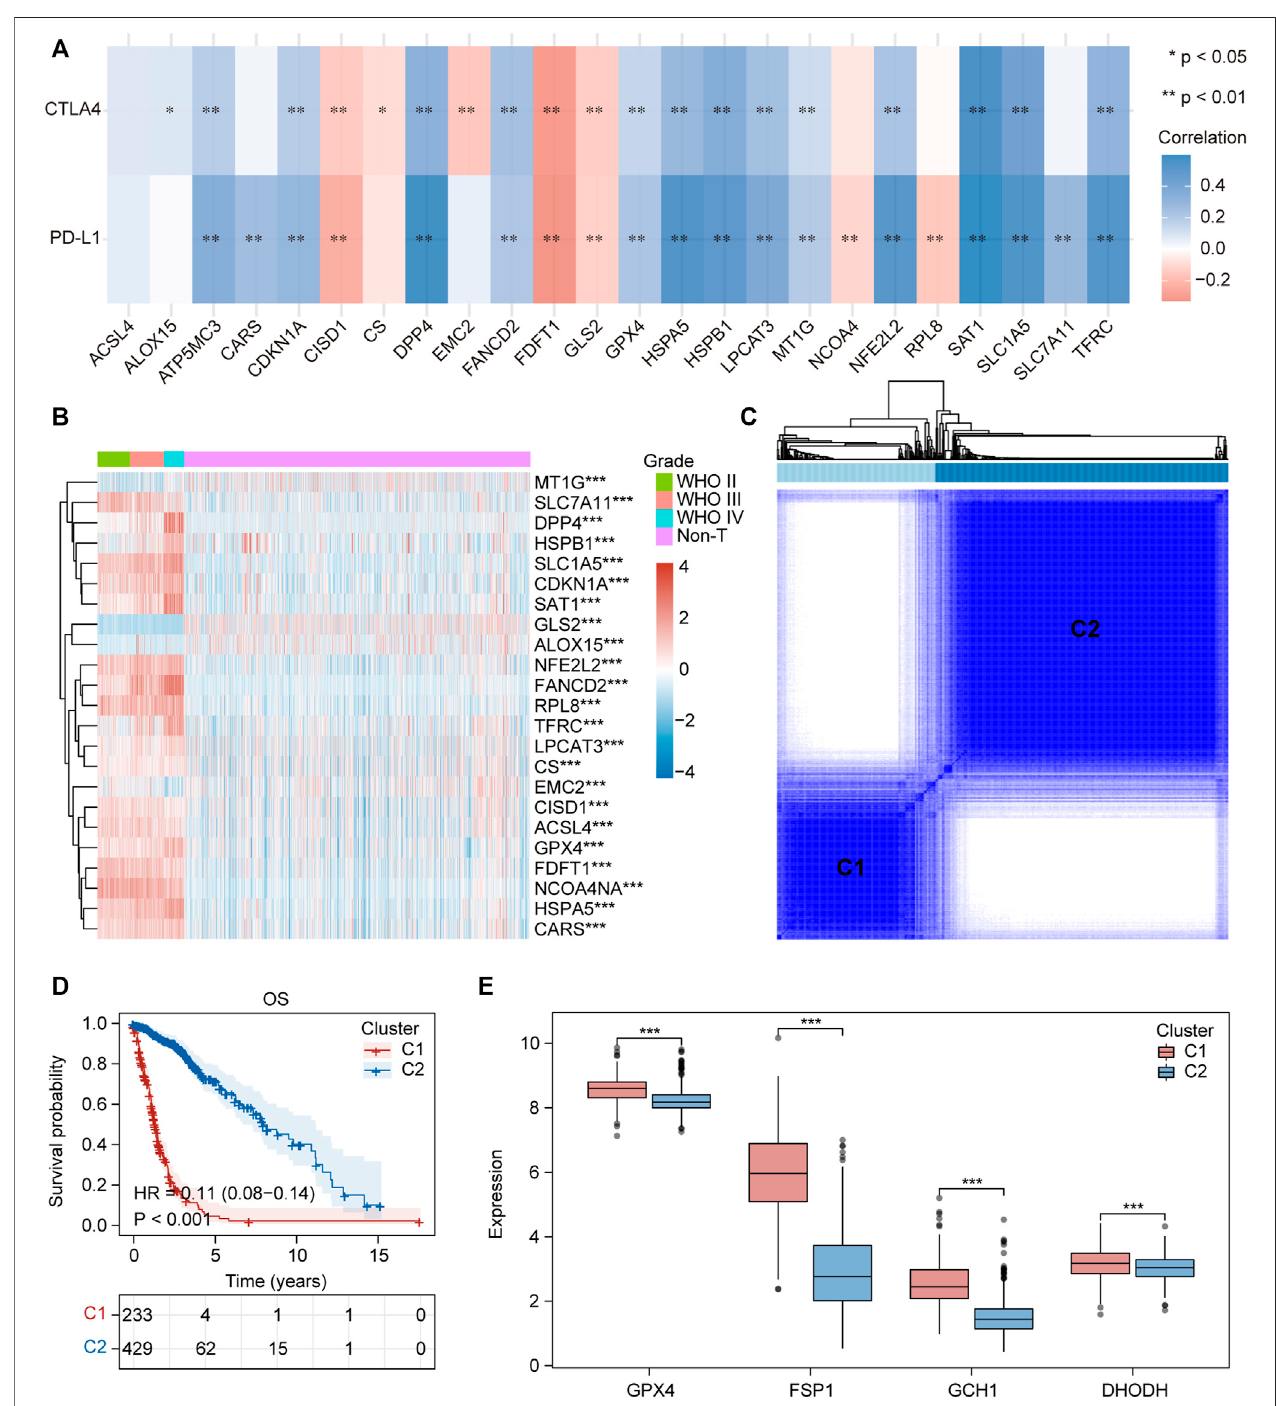
FIGURE 2 | Twoferroptosis-related subtypes were identi fi ed based on the expression pro fi le ofFRGs. (A) Correlation heatmap between 24 FRGs expression and PDL-L1 / CTAL4 . Blue, positive correlation; red, negative correlation. * p < 0.05, ** p < 0.01. (B) Heatmap depicted the FRGs expression pro fi le landscape in gliomas of TCGA database. Red, high expression, blue, low expression. (C) Consensus clustering matrix for k (cid:1) 2. (D) Kaplan – Meier analysis of patients in the two different ferroptosis-related subtypes. (E) Boxplots of GPX4 , GCH1 , FSP1 and DHODH expression level in the two different ferroptosis-related subtypes. ns, no signi fi cance; * p < 0.05; ** p < 0.01; *** p < 0.001.